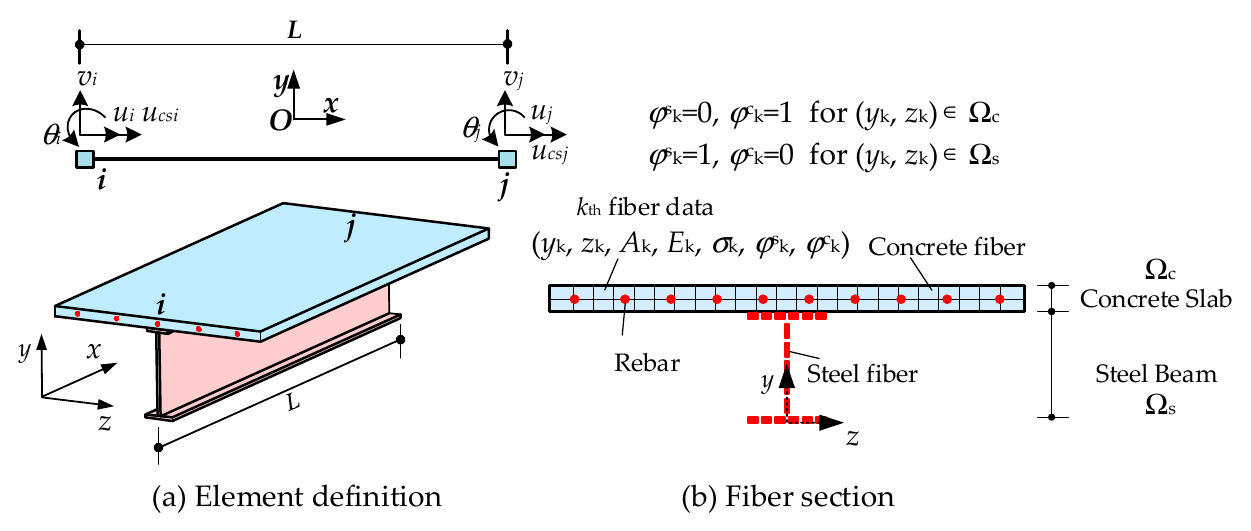
Figure 2. Fiber beam element and fiber section definition. The numbers of element nodes are named i and j . The element local coordinate axial x is defined along the element line and the yOz plane is defined in the cross-section, as shown in Figure 2. The displacement vector u and resistance vector F of the element are defined in Equations (1) and (2), respectively. The axial force N , shear force V , moment M and interfacial shear force F cs are defined as the resistance force concerning u , v , θ and u cs . The subscript i and j denote the corresponding nodal number.